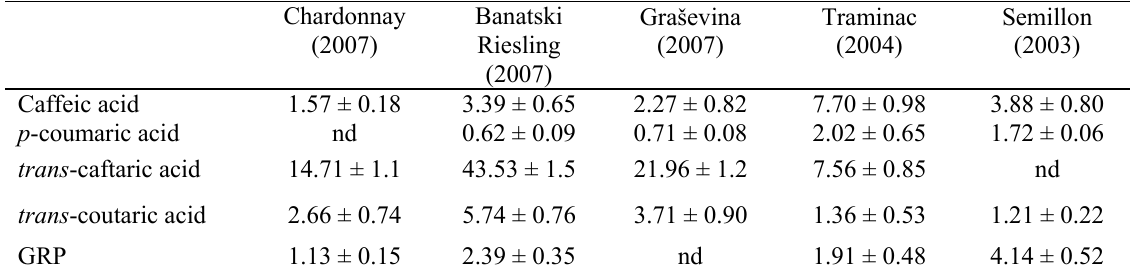
Table 4. Hydroxycinnamic acids (mg/L) of white wines.